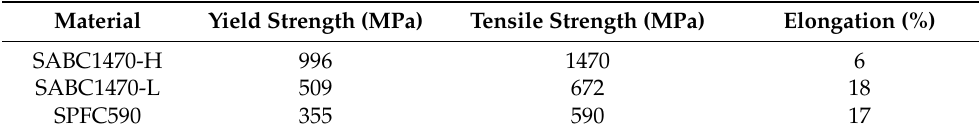
Table 4. Mechanical properties of center pillar with steel reinforcements